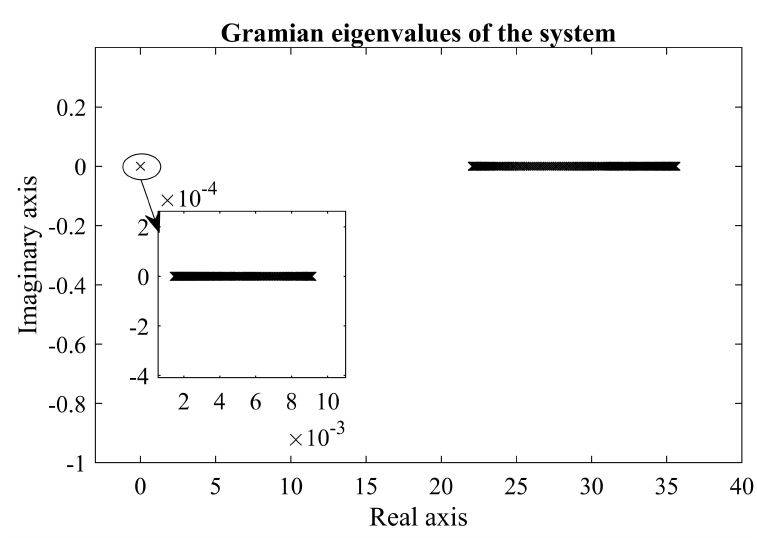
Figure 3. Gramian eigenvalues for range of rotor speed